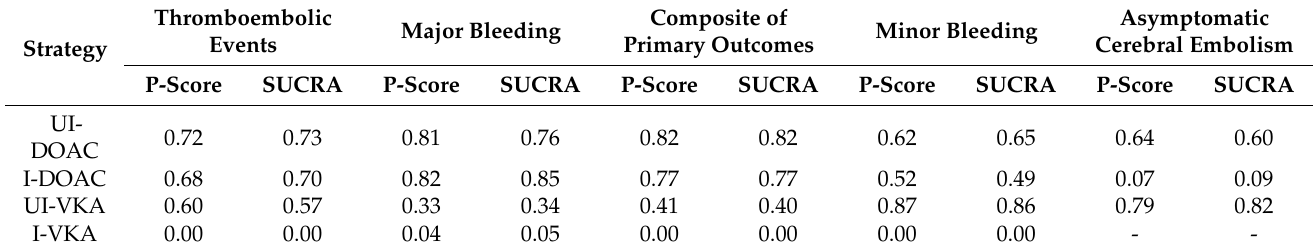
Table 2. P-score and the SUCRA values for each strategy and outcome.